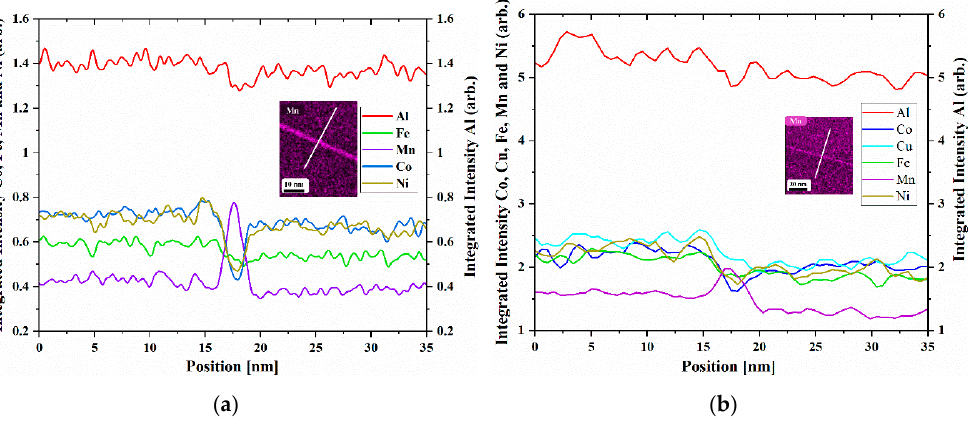
Figure 12. STEM-EDS composition line profile extracted across a grain boundary from the alloy ( a ) Al(CoFeMnNi) and ( b ) Al(CoCuFeMnNi) after humanizing for 144 h at 1373 K.